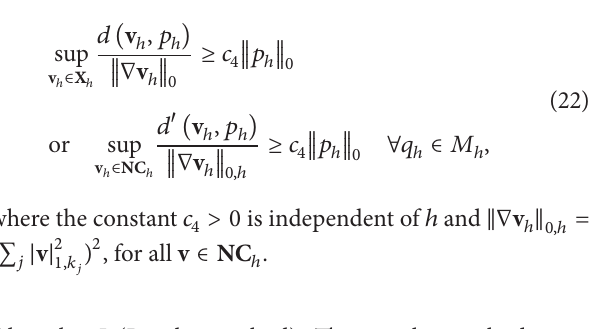
Algorithm I (Penalty method). The penalty method